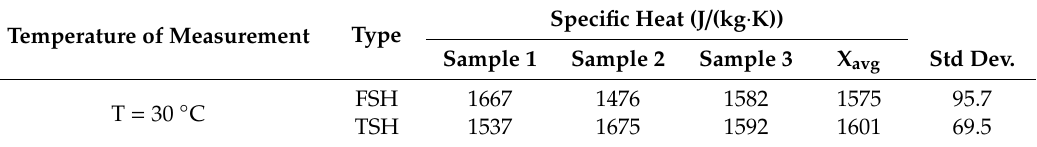
Table 6. Specific heat at T = 30 ◦